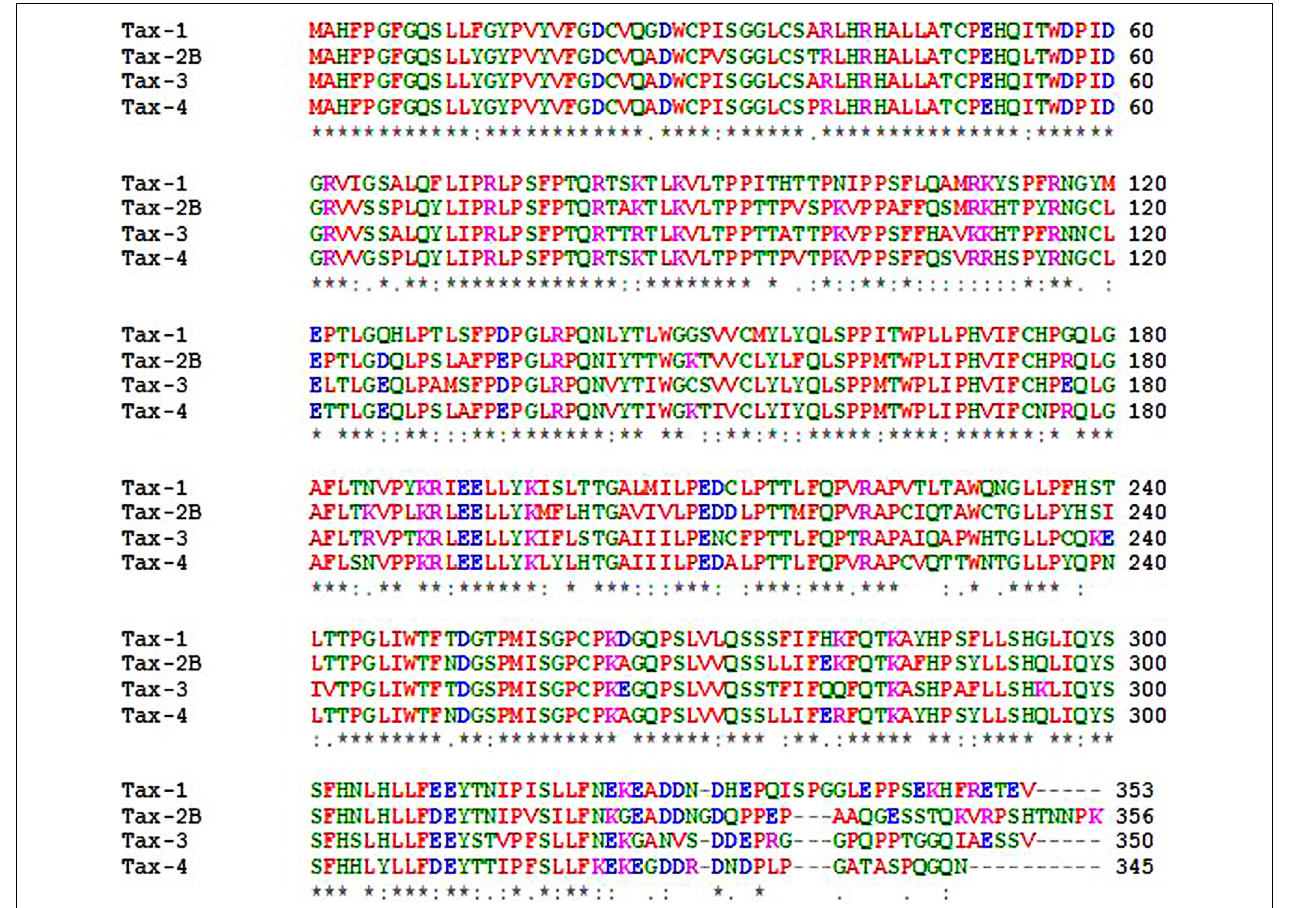
FIGURE 3 | ClustalW alignments ofTax-1,Tax-2B,Tax-3, andTax-4